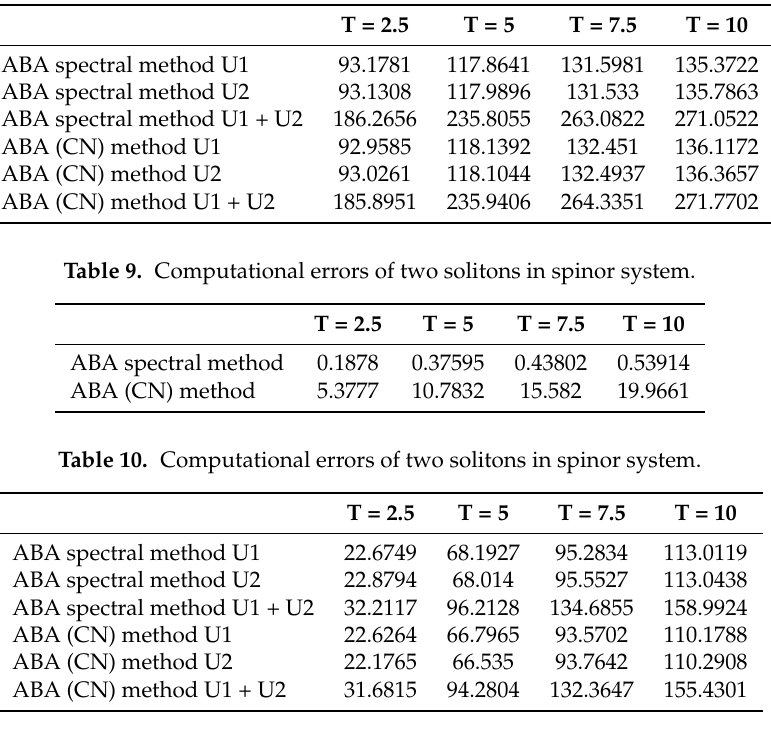
Table 8. Computational errors of one soliton in spinor system.